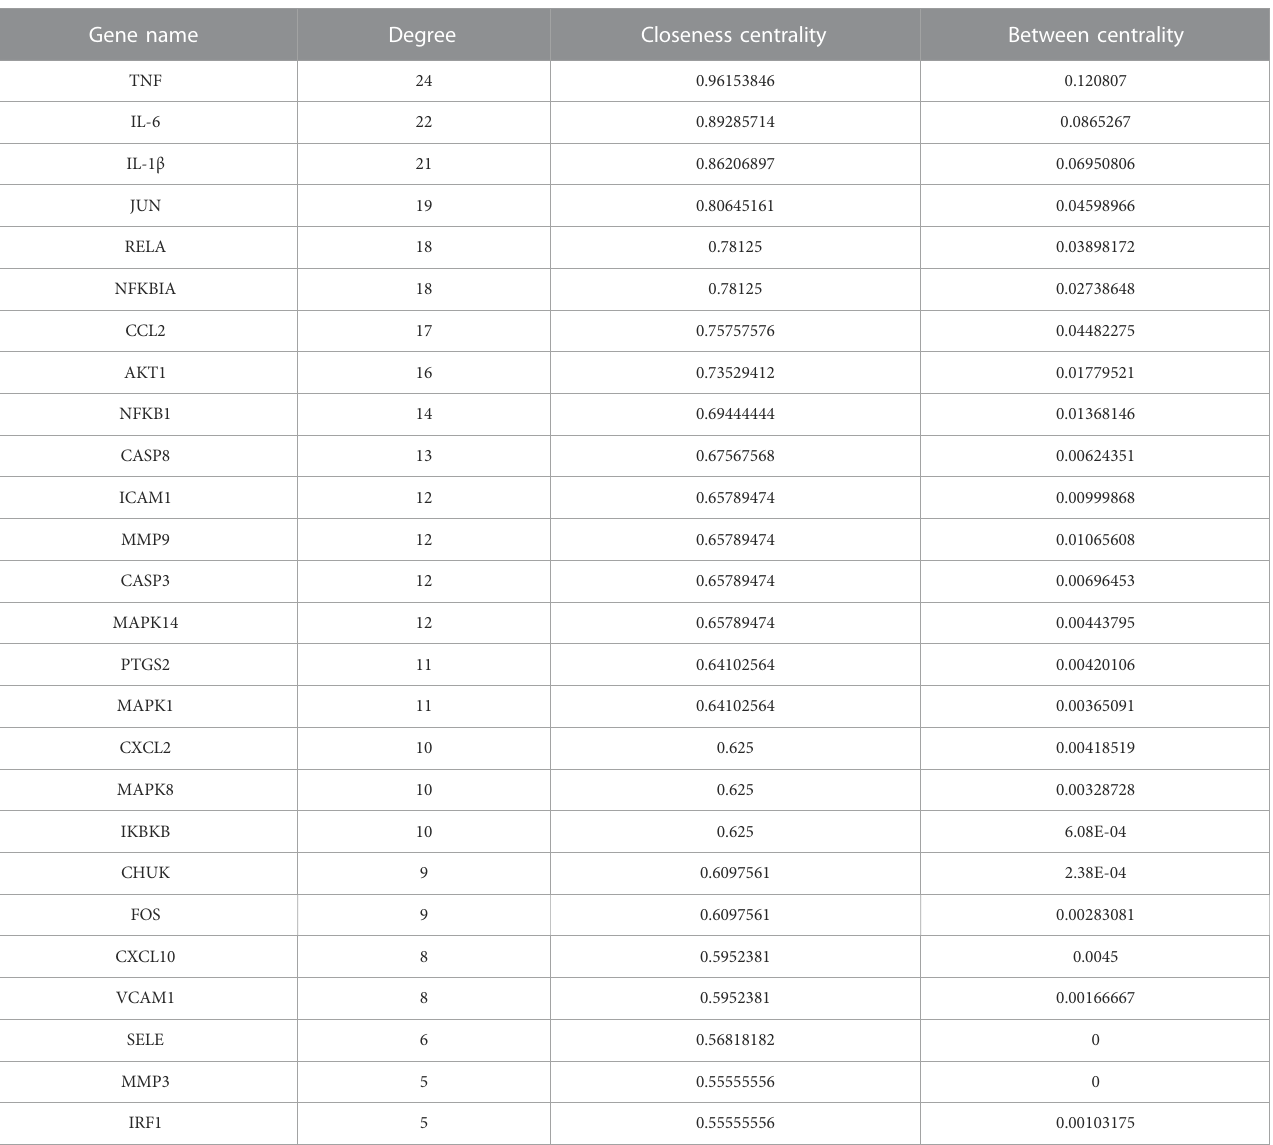
TABLE 3 PPI network details sorted by the degree value from STRING